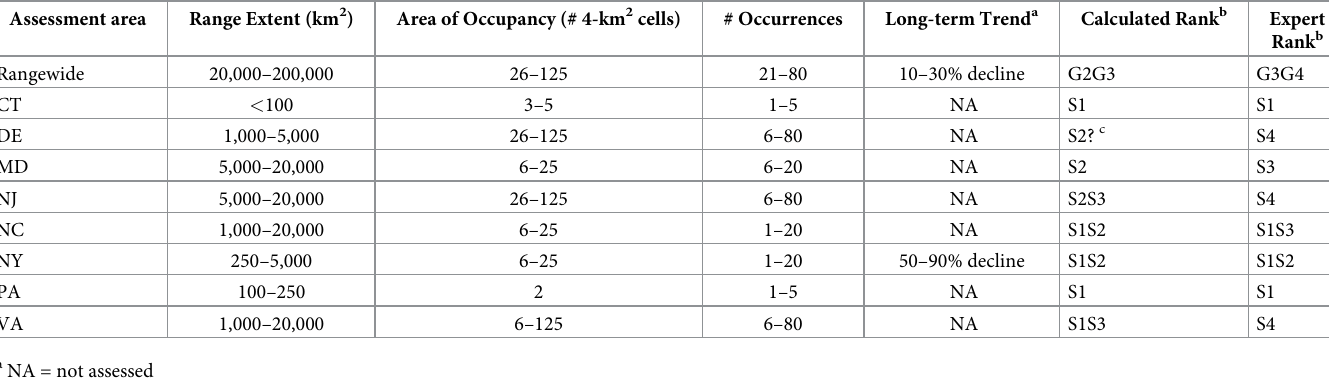
Table 2. Conservation status ranking of Rana kauffeldi using the NatureServe methodology [45,46]. Range extent is defined by the smallest polygon that encapsulates known occurrences. Area of occupancy is the area within the range in which the species actually occurs. Number of occurrences is intended to reflect number of popula- tions, based on taxon-specific distances within which animals are assumed to be interacting. Long-term trend was estimated based on historical literature or museum spec- imens. Values given for these rank factors are the ranges encompassed by NatureServe’s categories. Calculated rank was generated by NatureServe’s element rank calculator [46], while Expert rank was assigned by biologists familiar with the species in that state. Assessment